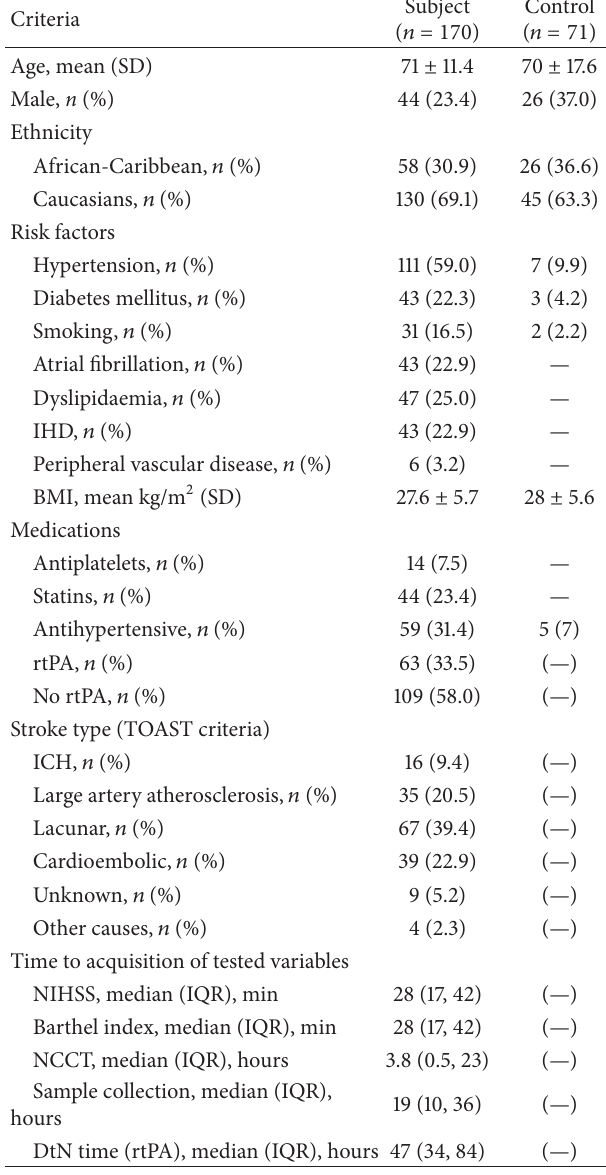
Table 1: Demographic characteristics of all